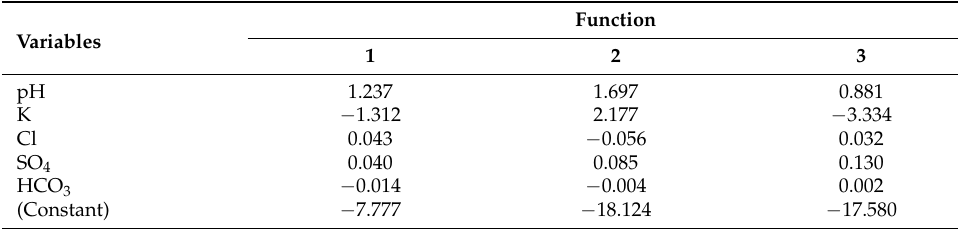
Table 12. The canonical discriminant function coefficients.